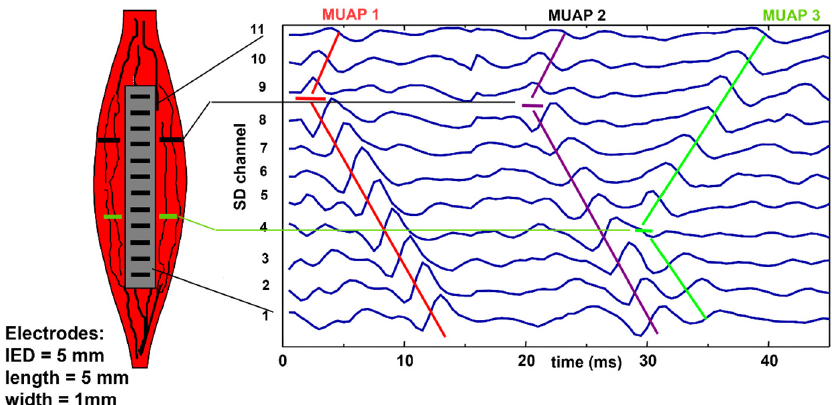
Figure 9. Example of experimental sEMG signals recorded with a 12-electrode array providing 11 single differential (SD) channels from a biceps brachii. In the 45-ms window, we can see the “signatures” of three MUs and locate their innervation zones. In this case, global conduction velocity (CV) can only be estimated in the proximal and distal regions of the muscle. In the middle region (Channels 4 to 8), some motor unit action potentials (MUAPs) propagate upward and some downward. The concept of global, or mean, muscle fiber CV is meaningless in this region and can only be estimated for individual MUs after extracting their MUAPs by means of sEMG decomposition [23]. IED = interelectrode distance. Reproduced from https://www.robertomerletti.it/en/emg/material/teaching/module6.